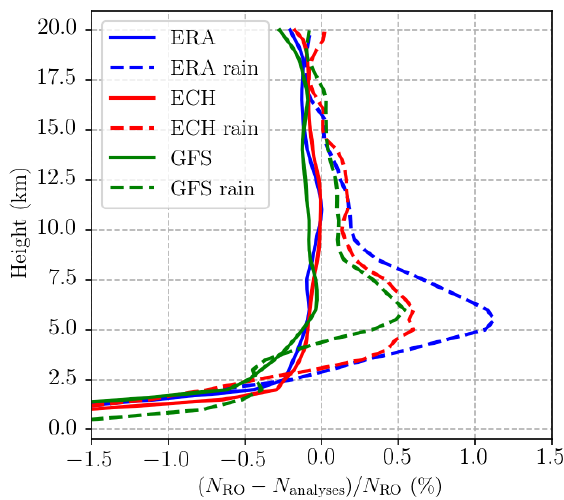
Figure 2. Fractional difference between the RO-observed refrac- tivity and that from (blue) ERA-Interim, (red) ECMWF high- resolution analysis, and (green) NCEP GFS operational analysis. The RO profiles are divided into no rain (solid) and heavy rain (dashed) based on the collocated GPM IMERG precipitation mea- surements (see Sect. 2.2). These data correspond to